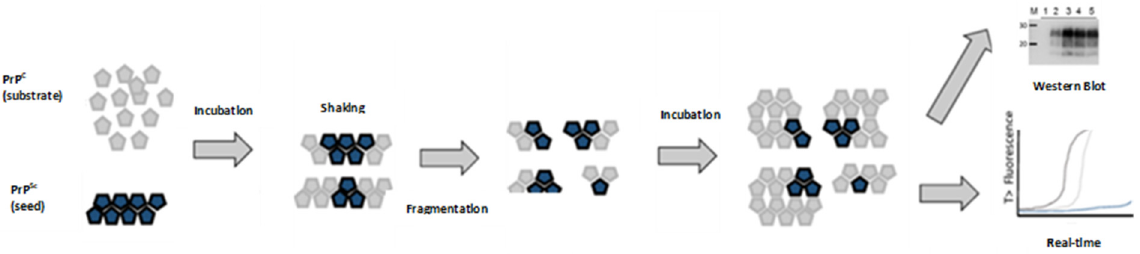
Figure 8. Principle of real-time quaking-induced conversion (RT-QuIC). Adapted from Ref. [79].